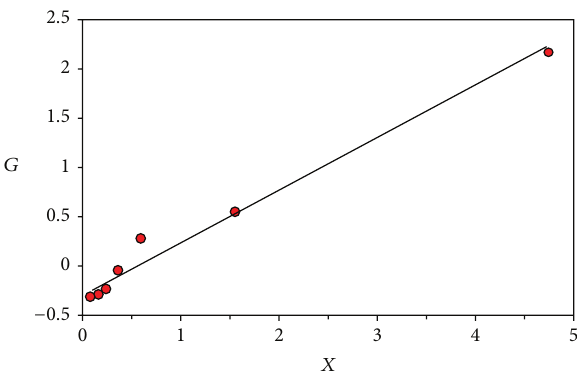
Figure 3: Fineman-Ross plot of TMEVS/NVP